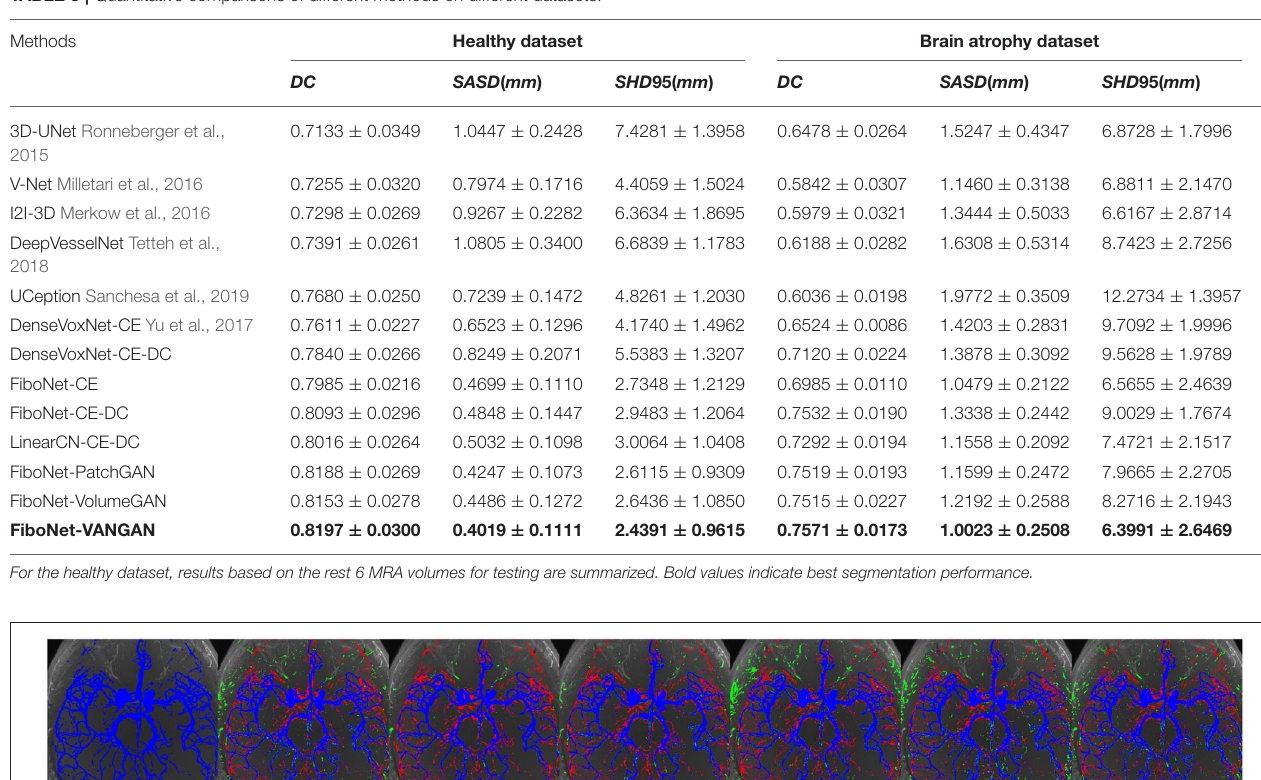
TABLE 3 | Quantitative comparisons of different methods on different datasets.